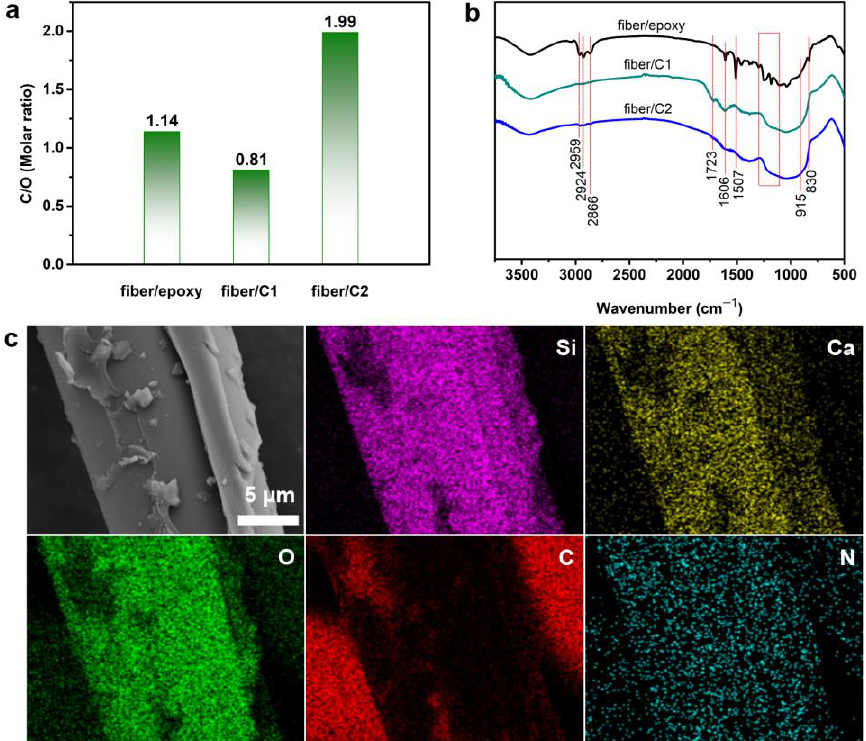
Figure 3. Molar ratio of C/O of the fiber/epoxy composite, fiber/C1, and fiber/C2 ( a ); FTIR spectra of the fiber/epoxy composite, fiber/C1, and fiber/C2 ( b ); SEM imaging of fiber/C2 ( c